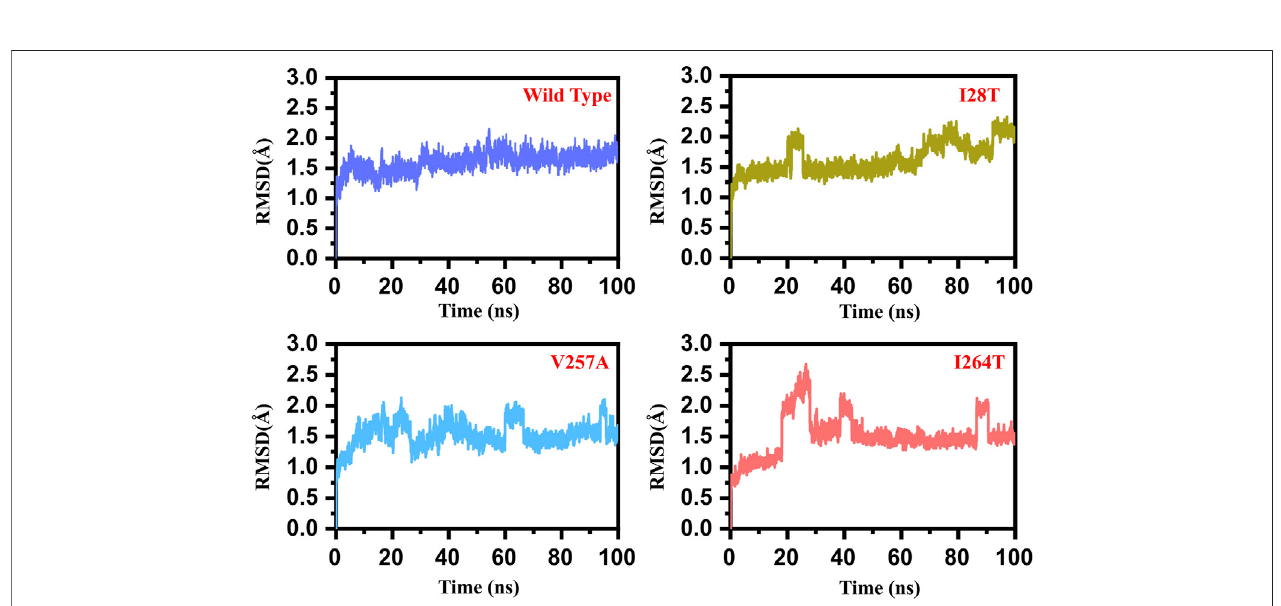
FIGURE 5 | RMSD graph of the WT and mutants (I28T, V257A, and I264S). The x -axis shows the time in nanoseconds, while the y -axis shows the RMSD in angstrom. (A) Wild type; (B) I28T; (C) V257A; (D) I264S.